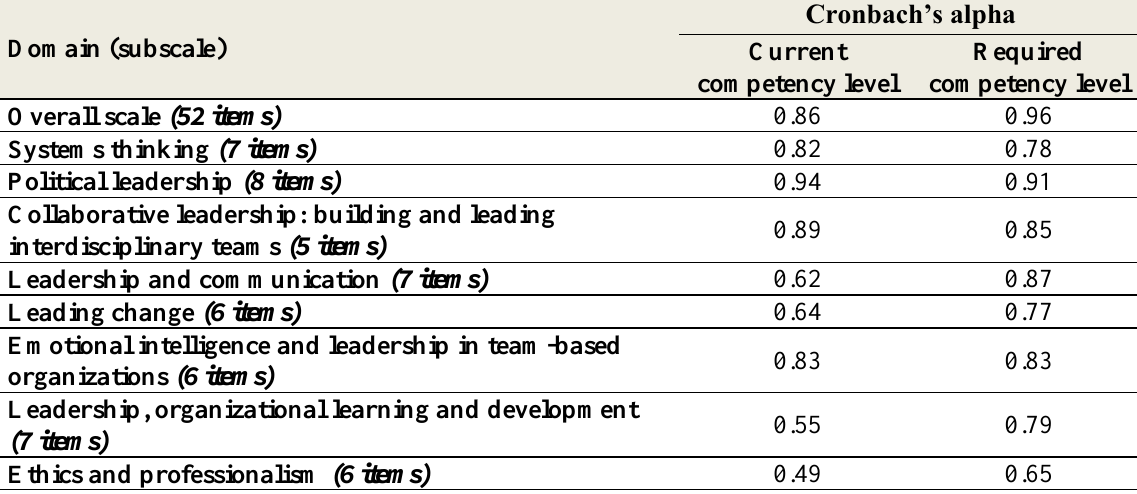
Table 2. Internal consistency of the leadership competency instrument administered in a representative sample of health professionals in Albania (N=267)